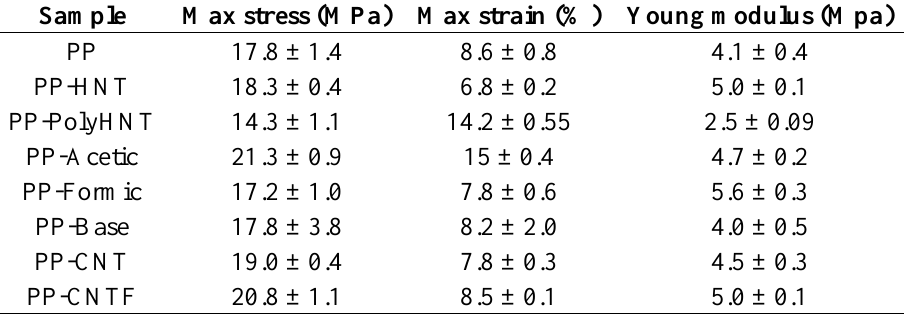
Table 7. Mechanical properties of pure PP, PP/silanes and PP/filler composites (3